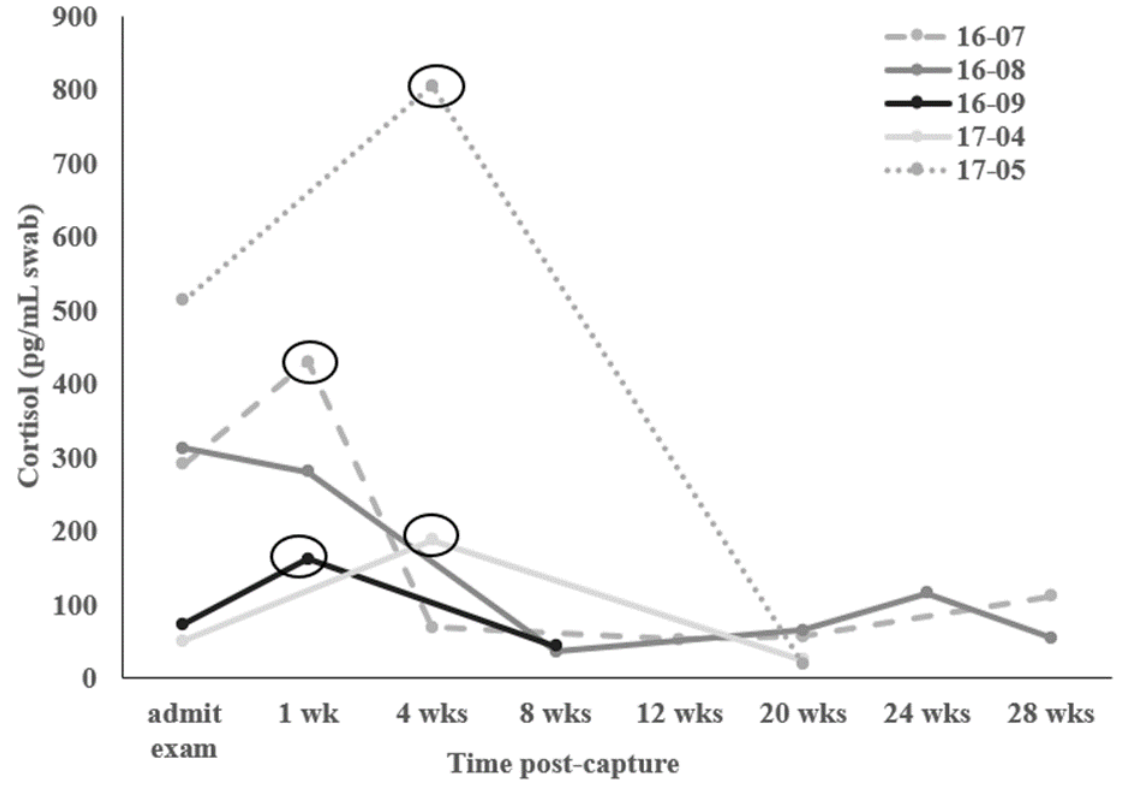
Figure 1. Skin mucus cortisol values (pg/mL swab) from admittance examination upon capture from the Monterey Bay (Monterey, CA, USA) through 28 weeks post-capture for five mola individuals. Circles indicate an elevated cortisol value (≥1.5-fold increase [33]) compared to the first, initial sample taken during the admittance exam.